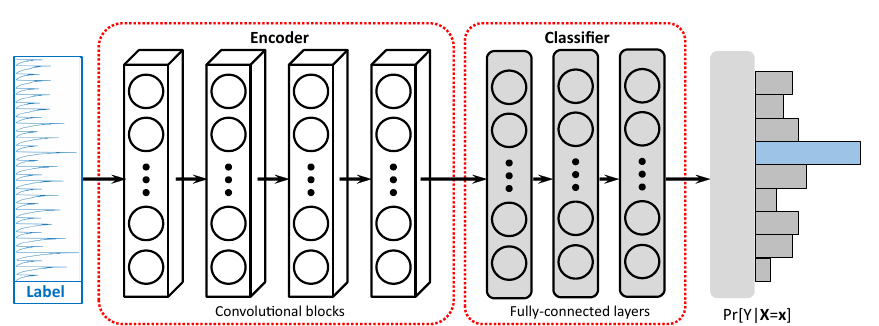
Figure 2: An example scheme of the CNN